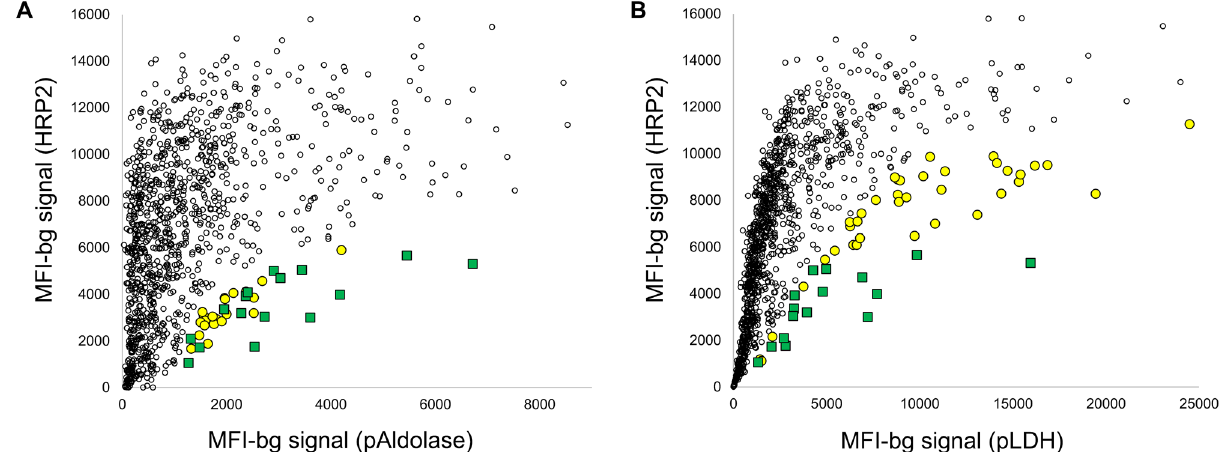
Figure 3. Multiplex antigen detection and sample selection for genetic assays. Scatter plots comparing the MFI-bg signal for pAldolase (panel A ) or pLDH (panel B ) antigen signal on the x-axis in comparison with HRP2 assay signal on the y-axis. Yellow circles indicate samples selected for either pAldolase or pLDH, green circles indicate samples selected based on both pan- Plasmodium